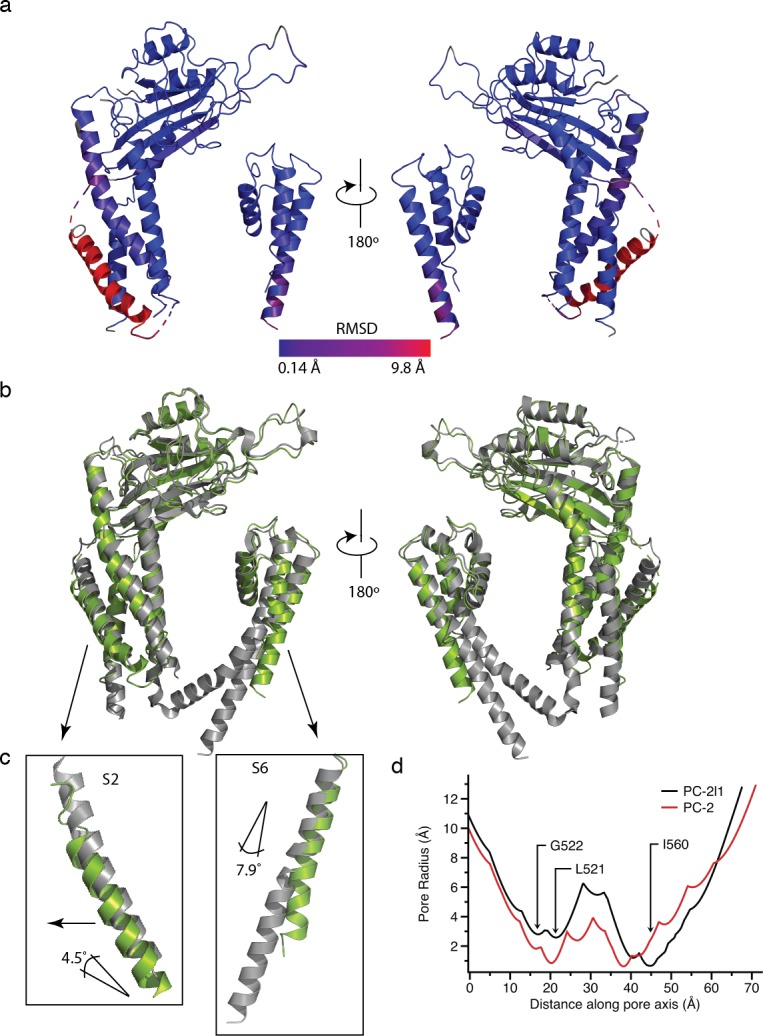
Comparison of polycystin 2-l1 and polycystin-2.(a) The Cα-RMSD between polycystin 2-l1 and polycystin-2 (5T4D) mapped onto the polycystin 2-l1 monomer. The average RMSD is 1.5 Å with a range of 0.14 Å (blue) to 9.8 Å (red). (b) Overlay of the polycystin 2-l1 monomer (green) on the polycystin 2 (gray) monomer; cartoon representation. (c) Polycystin 2-l1 S2 segment (green) and polycystin 2 S2 (gray), showing the relative angle and lateral shift (arrow). S6 relative angle shown at right. (d) Calculation of pore radius (Å) along the pore axis for polycystin-2 (red) and polycystin 2-l1 (black). Residues G522 and L521 in the selectivity filter, and I560 are labeled and are the three narrowest distances.